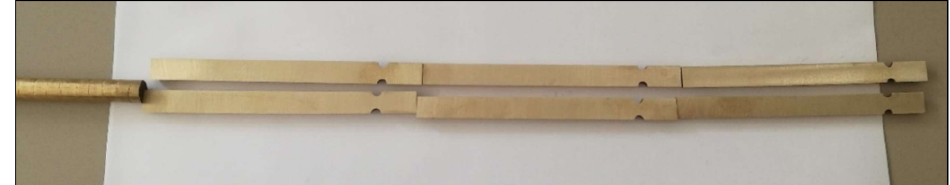
Figure 2. Presentation of CuAlNi casting and cut-off samples for corrosion testing.